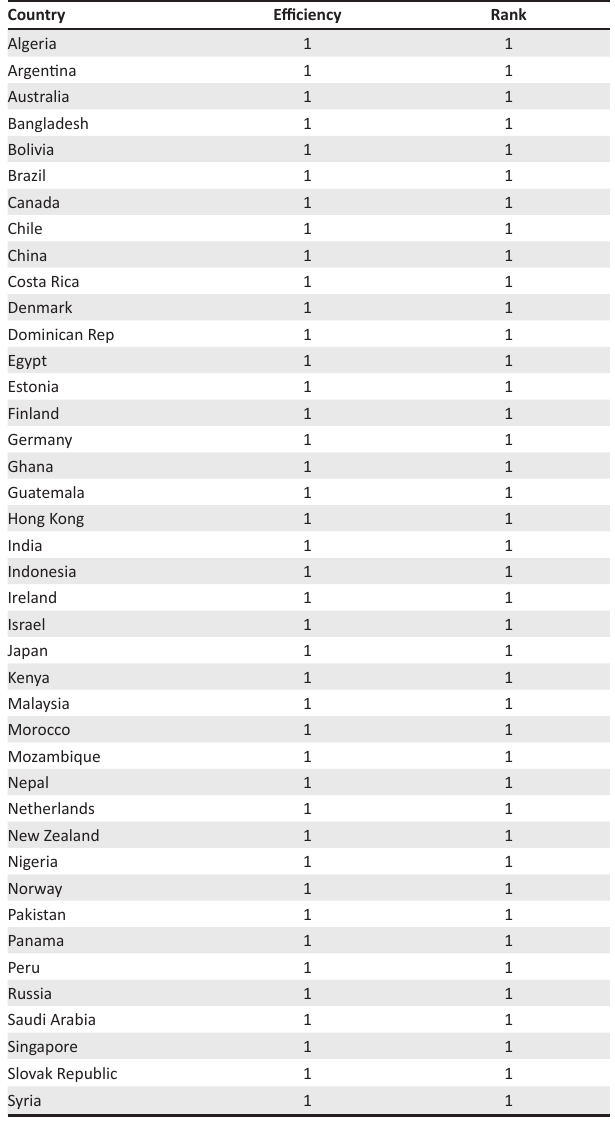
TABLE 3: Country efficiency scores.